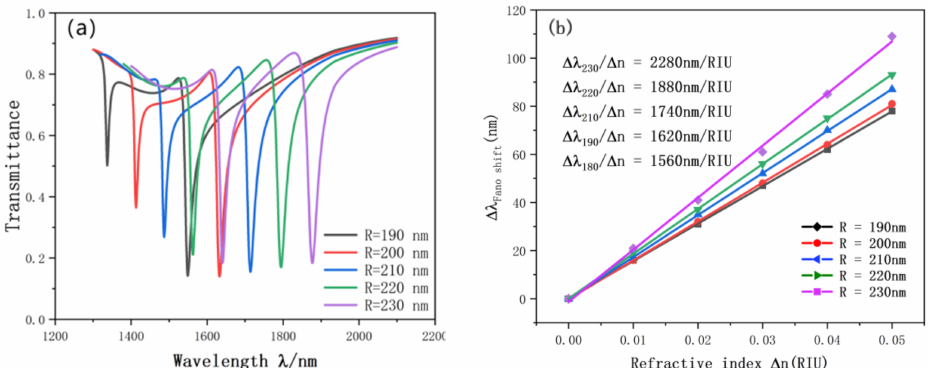
Figure 7. ( a ) Transmission spectrum of R variation; ( b ) the sensitivity of R changes to fit the line. In order to further explore the factors affecting the accuracy of the sensor, we also carried out experiments on the rectangular cavity on the double ring. The resonance curve changes as the length and width of the rectangular cavity keep changing. As illustrated in Figure 8, we increased the length of the rectangular cavity from 180 nm to 220 nm and the width from 30 nm to 50 nm. During this process, with the continuous change of the length and width of the rectangular cavity, the Fano curve showed an obvious red shift, and the figure basically did not change. The reason is that the SPP can be better excited by proper adjustment of the rectangular cavity. According to the fitting straight line in Figure 9, the length and width of the rectangular cavity have a great influence on the accuracy of the sensor. The sensitivity is from 1990 nm/RIU to 2280 nm/RIU, the maximum advantage value is 76.7, l = 220, d = 50 nm, which is the best choice for structure and